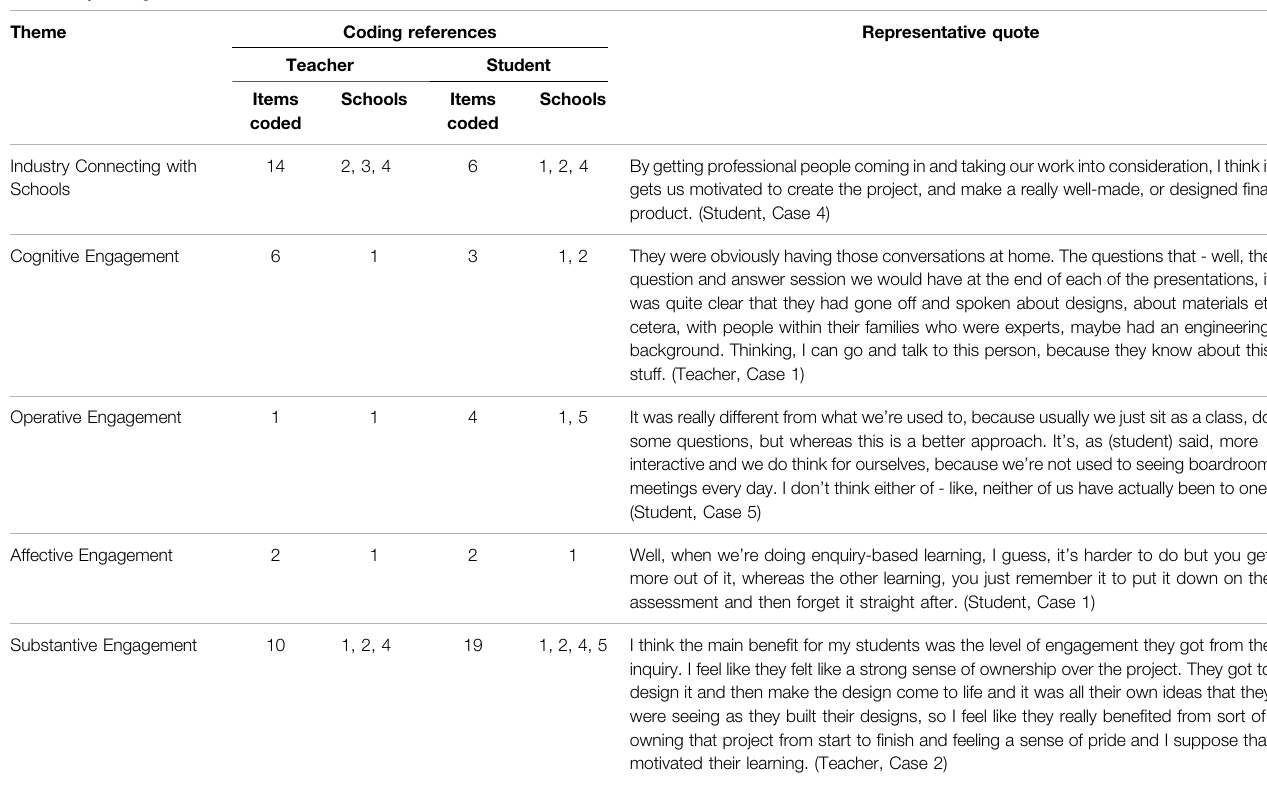
TABLE 4 | Coding for additional